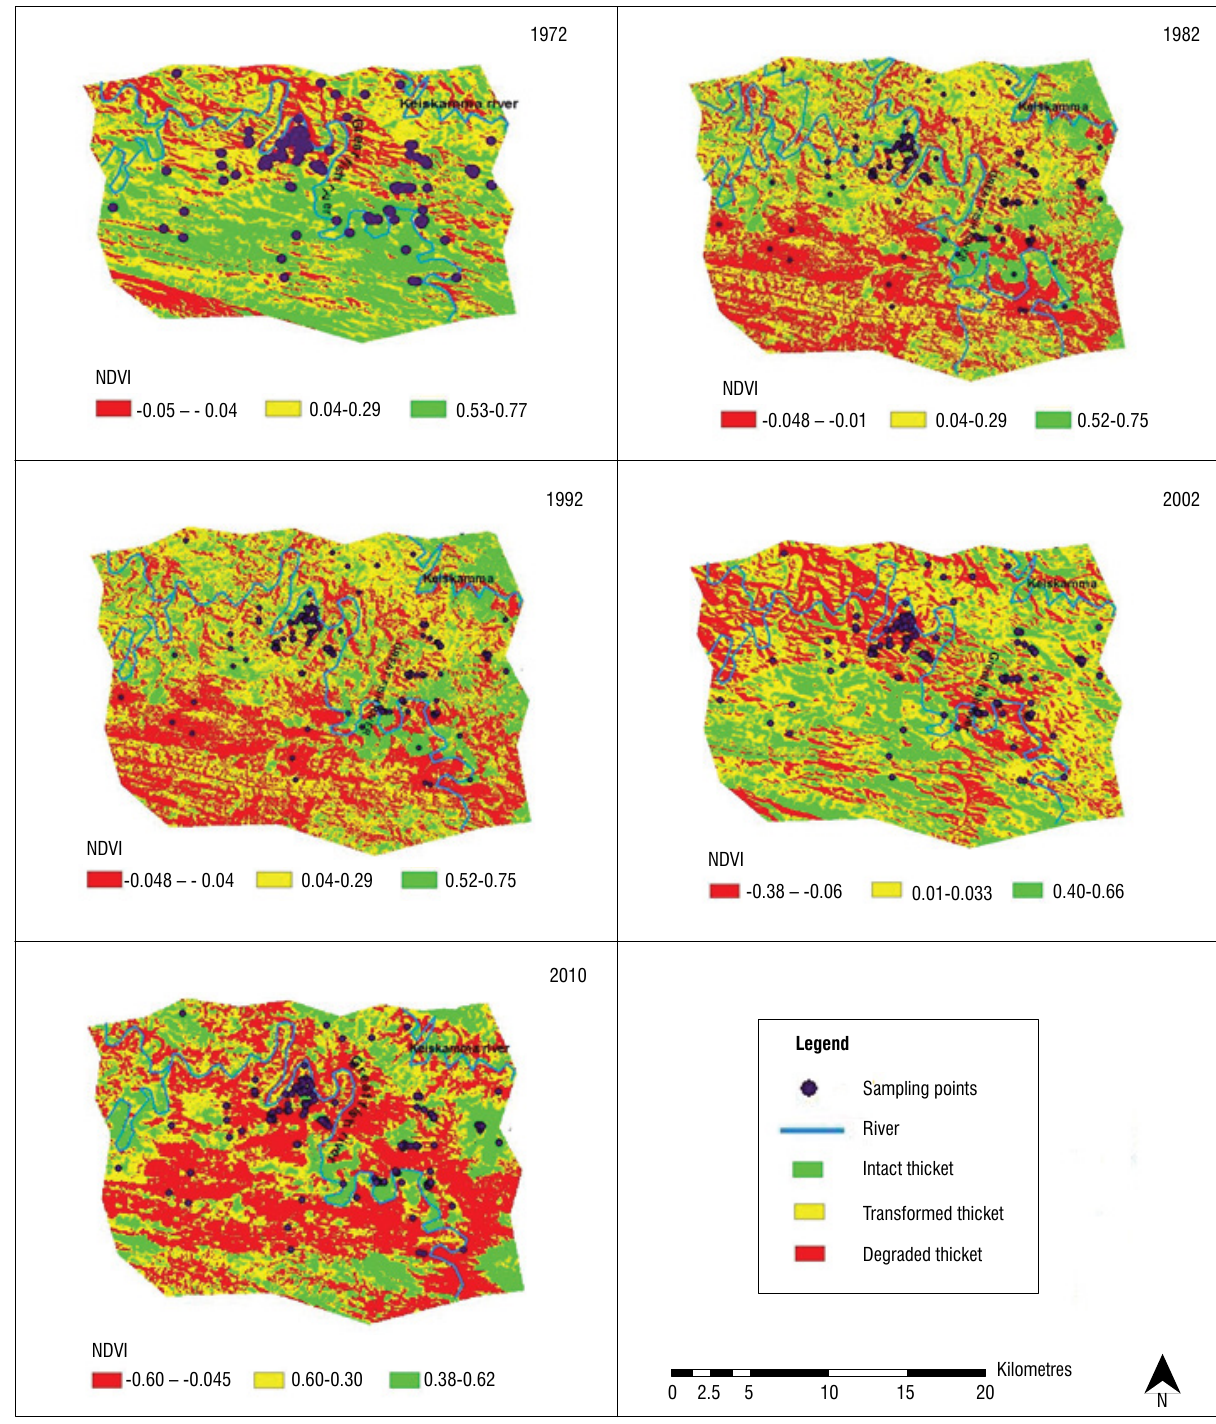
Figure 3: Normalised Difference Vegetation Index (NDVI) ranges per class from 1972 to 2010. The dots on the NDVI surfaces represent field sampling